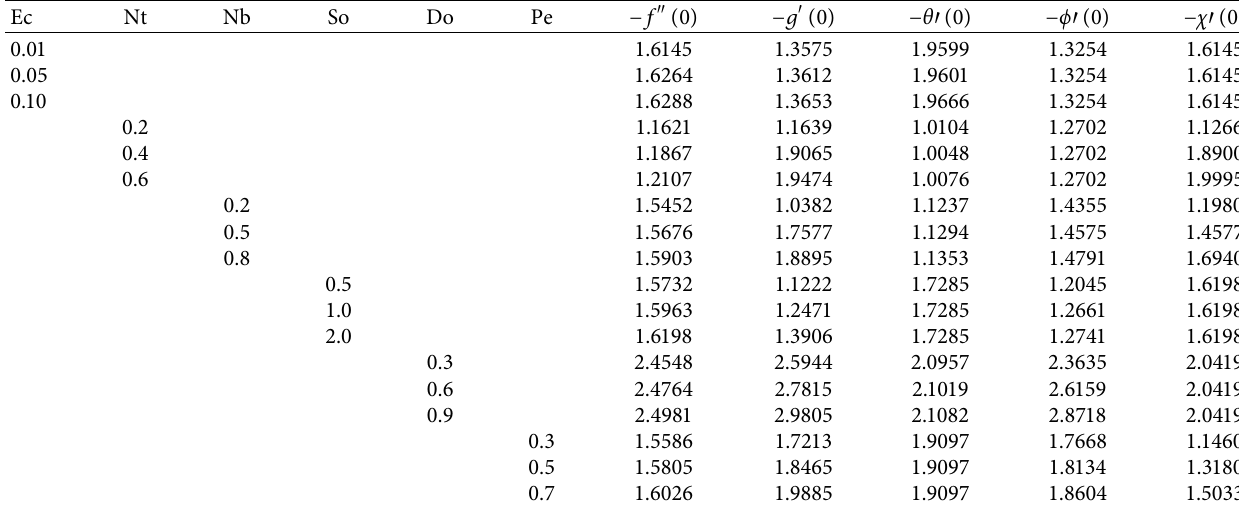
Table 2: Computational values of skin friction, Nusselt number, and Sherwood number for key fow parameters II. Ec